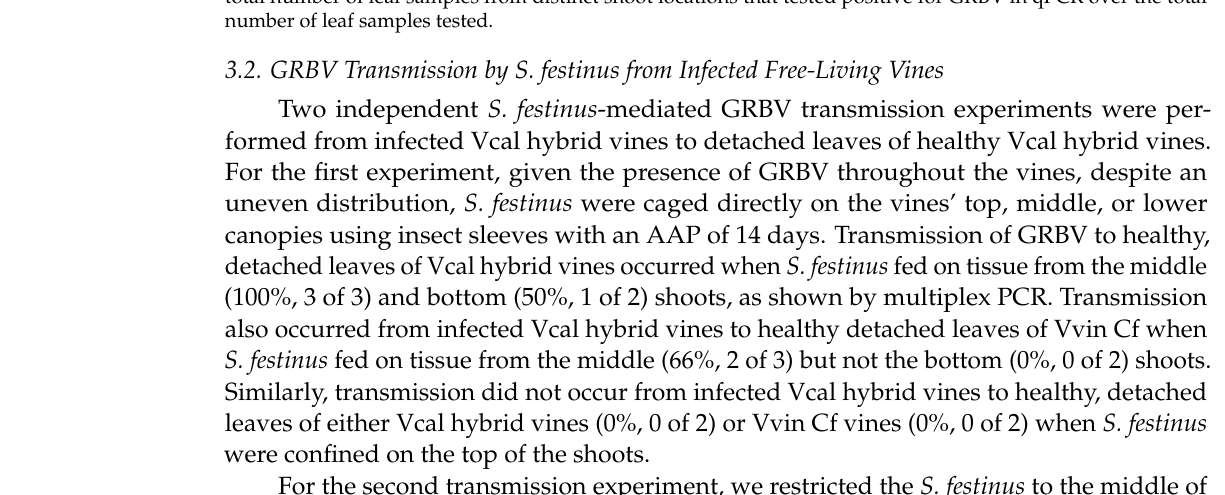
a Two free-living vines (1 and 2) growing in the greenhouse were selected for this analysis. Three leaf samples from two shoots (A and B) and three shoot locations (bottom, middle, and top) of each vine were collected and tested for GRBV by qPCR. Data represent the number of leaf samples that tested positive for GRBV in qPCR over the total number of leaf samples tested. The free-living vines were first generation hybrids of V. californica and V. vinifera ‘Sauvignon blanc’; b Data represent the total number of leaf samples from distinct shoots and shoot locations that tested positive for GRBV